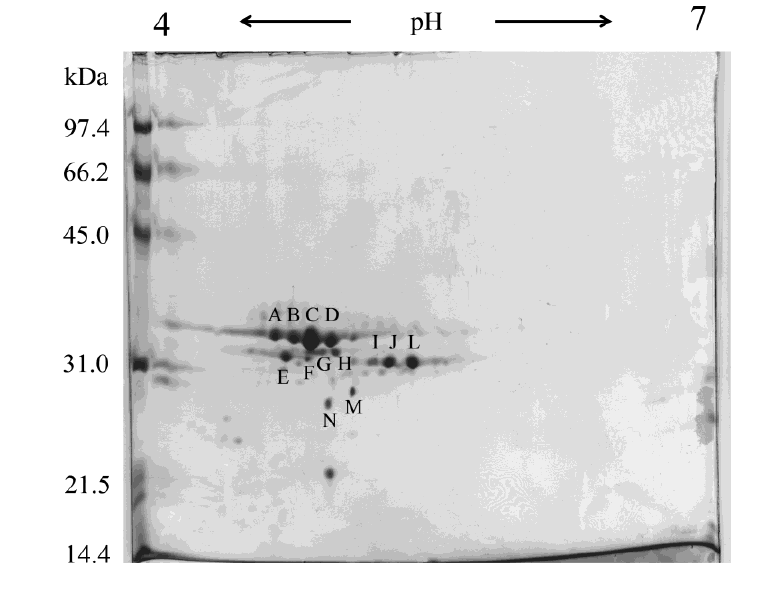
Figure 1. Two-dimensional electrophoresis (2-DE) analysis on donkey milk whole casein.